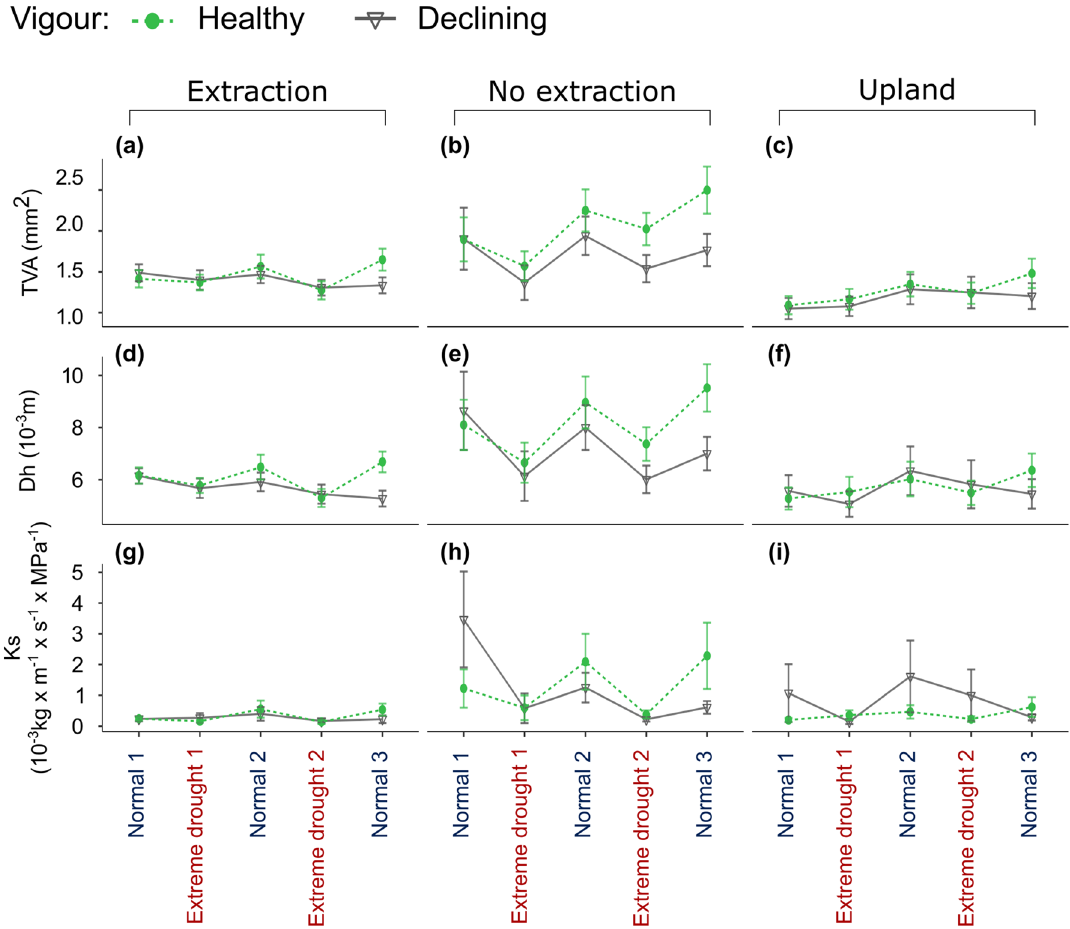
Figure 5. Development of vessel-related variables: ( a – c ) total vessel area (TVA); ( d – f ) hydraulic diameter (Dh); ( g – i ) theoretical hydraulic conductivity (Ks), in in the two droughts as well as pre, and post-drought (normal) periods for trees from different vigour groups and sites with different groundwater regimes. See also Supplementary Fig. S3 for the exact non-dry years considered in the pre- and post-drought periods. Points show average values of each vessel related variables and bars show the standard error of the